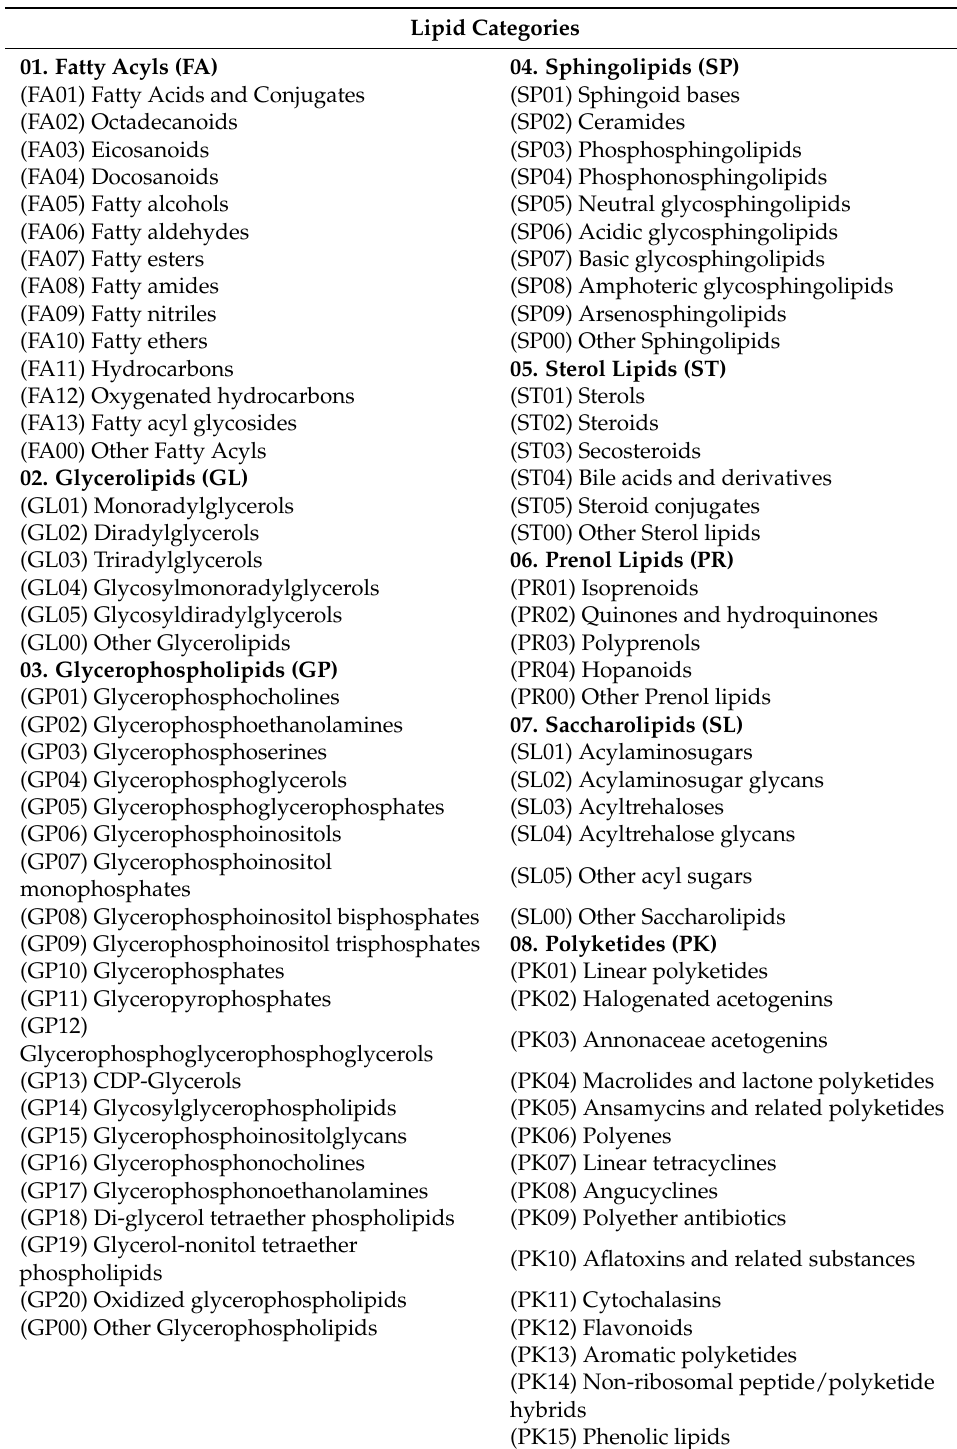
Table 1. Lipid classification based on Lipid Maps Structure